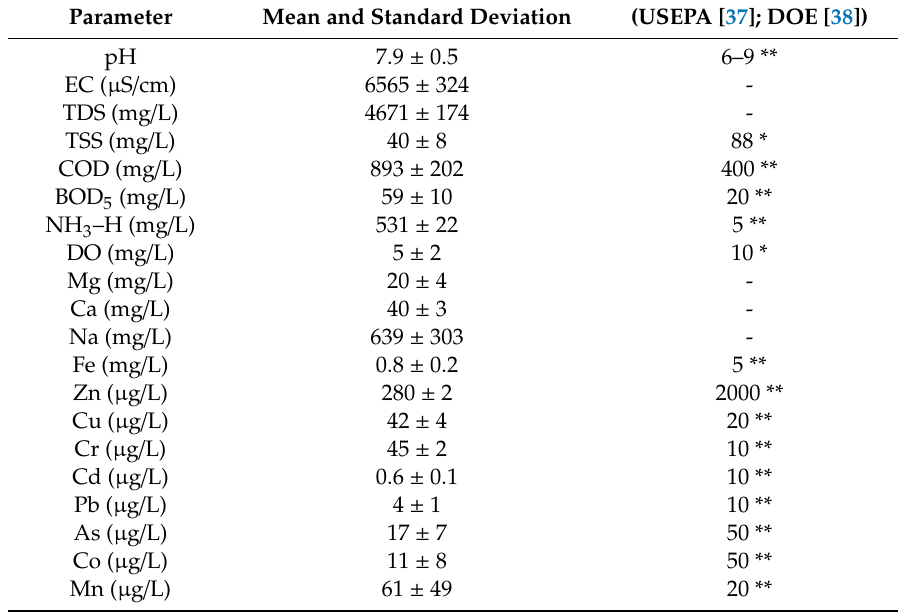
Table 1. Descriptive statistics including the mean and standard deviation of leachate quality parameters and heavy metals.